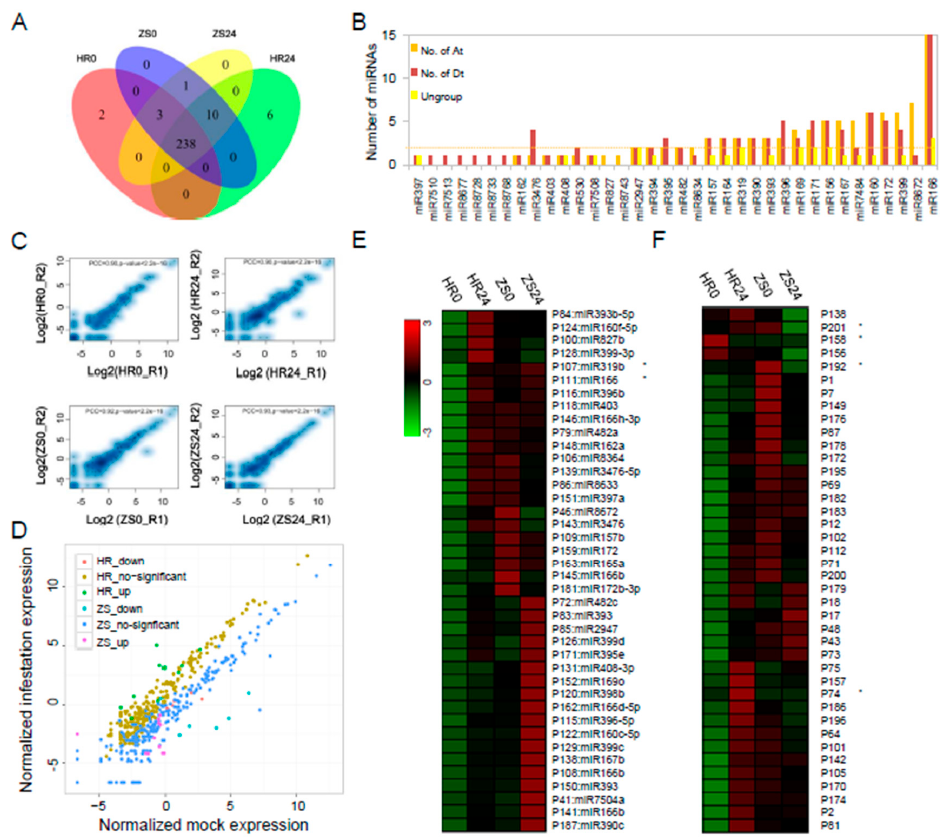
Figure 2. Comparative analysis of miRNAs and their expression profiles between whitefly-resistant (HR) and whitefly-susceptible (ZS) cotton plants during whitefly infestation. ( A ) The number of miRNAs following whitefly infestation in the HR and ZS cultivars. ( B ) The number of conserved pre-miRNAs in the A t -, D t -subgenomes and ungroup (scaffold). ( C ) Expression level (RPM) correlation of allthe miRNAs calculated by PCC in two biological replicates. ( D ) Scatter-plot graph representing